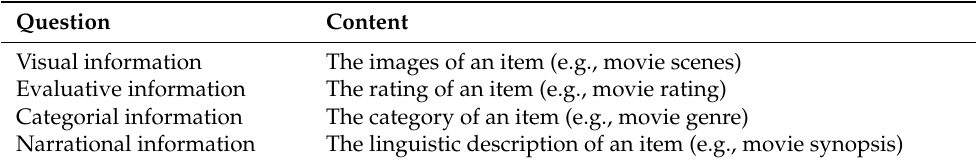
Table 1. Hypothesized cues for the research